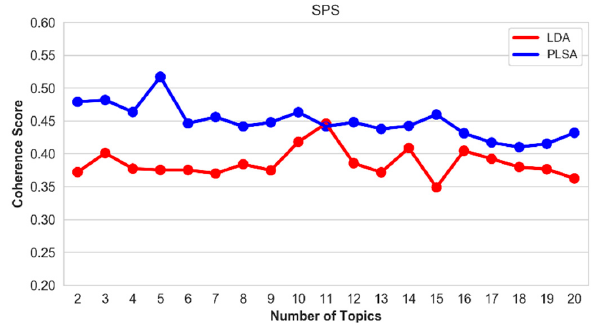
Figure 12. Coherence score of the top-20 topics on the SPS hallmark.